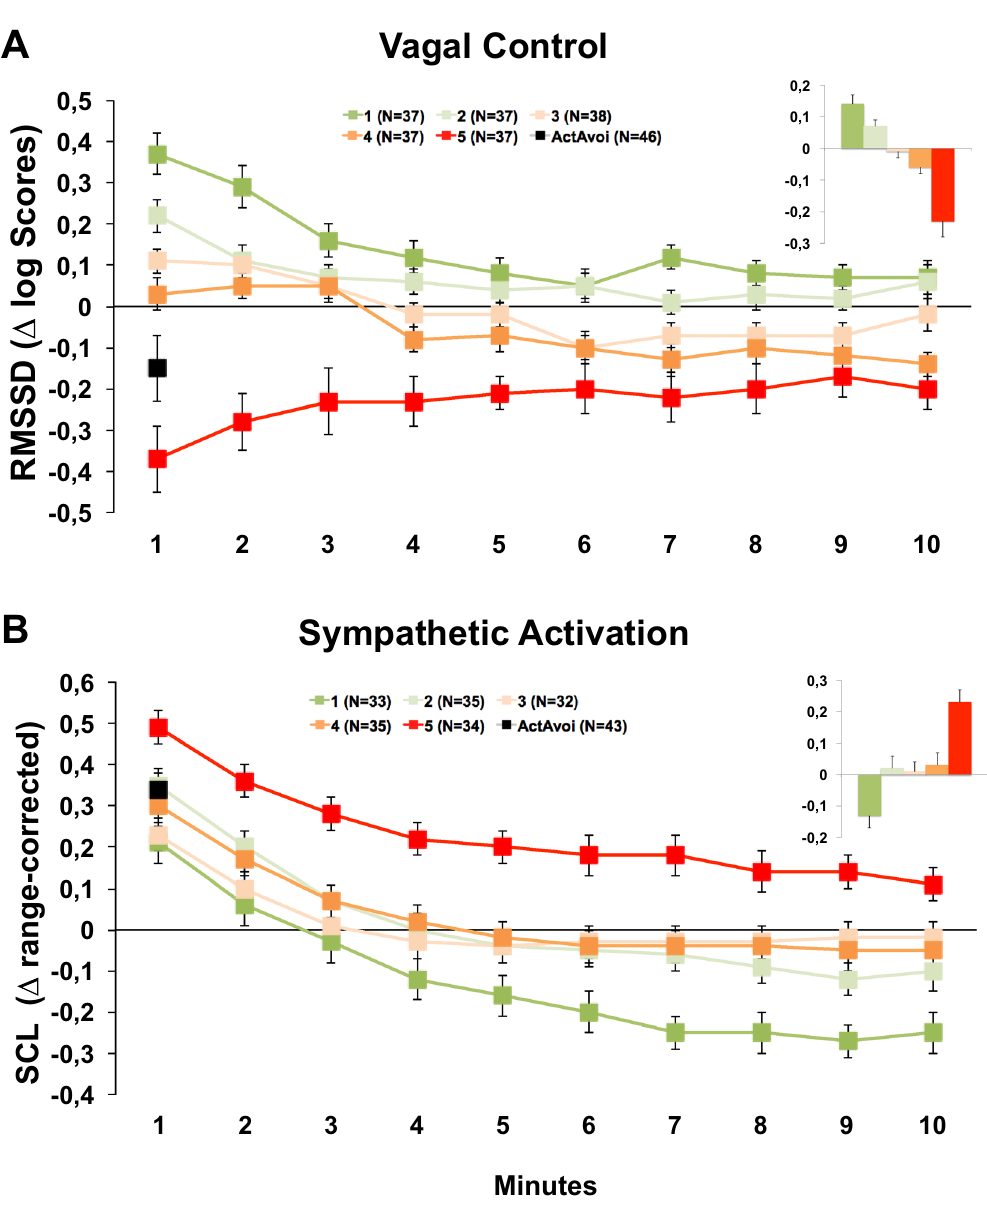
Figure 2. Vagal tone ( A ) and sympathetic activation ( B ; means and standard errors) during 10 mins of acute threat exposure and averaged across the whole threat exposure (embedded figure) relative to a safe condition in n = 186 patients with no avoidance behavior during the task as a function of heart rate reactivity groups with increasing heart rate responses indicating increasing threat imminence. For comparison the responses during the first minute of exposure were also presented for n = 46 patients showing active avoidance but a minimum exposure duration of 60 s. ( A ) Heart rate variability in logarithmic RMSSD scores, root mean square of successive differences. ( B ) Range corrected skin conductance levels (SCL) in 212 patients with available